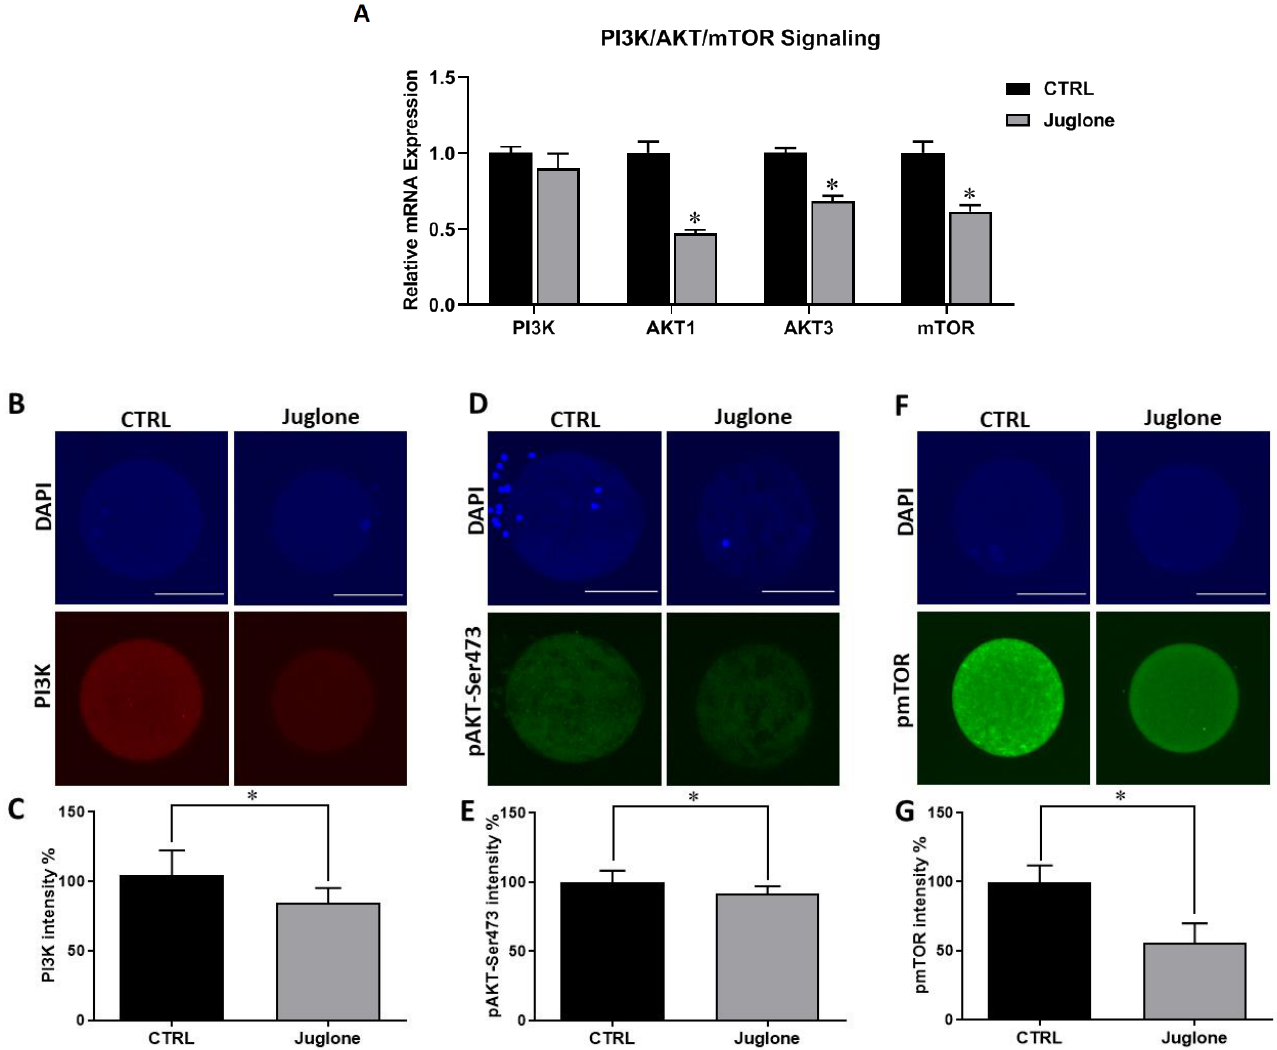
Figure 2. The effect of juglone on the PI3K/AKT/mTOR pathway in oocytes. Bovine oocytes were exposed to 25 µ M of juglone during in vitro maturation (IVM), three replicate (n = 50), and four replicates (n = 20) were used for RT-qPCR and immunofluorescence analysis, respectively. ( A ) Relative expression of PI3K, AKT, and mTOR genes using RT-qPCR. ( B , D , F ) Immunofluorescence of PI3K, pAKT, and pmTOR in juglone treated and untreated oocytes. ( C , E , G ) Fluorescence intensities of PI3K, pAKT-Ser473, and pmTOR in juglone-treated and control groups. Scale bar = 100 µ m. Columns with an asterisk (*) indicate statistical significance. DAPI: 4 (cid:48) ,6-diamidino-2-phenylindole. pAKT: phosphorylated AKT; and pmTOR: phosphorylated